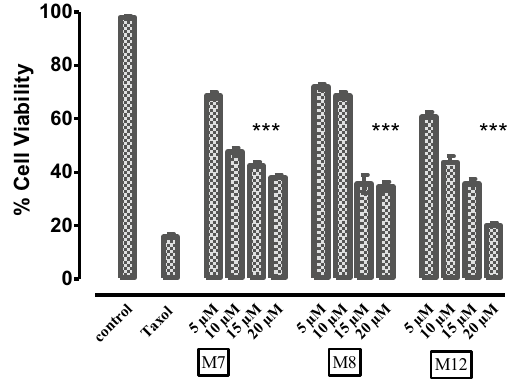
Figure 11. % Cell viability of HepG2 cells after treatment with potent derivatives (M7, M8 and M12) by using Taxol as Positive Control. The cells were treated with four different concentrations (5 µM, 10 µM, 15 µM and 20 µM) for 48 h and cell viability was measured by MTT assay. Data were analyzed as mean of three experiments ± S.D. (n = 3) by using PRISM 5 (GraphPad, San Diego, California,